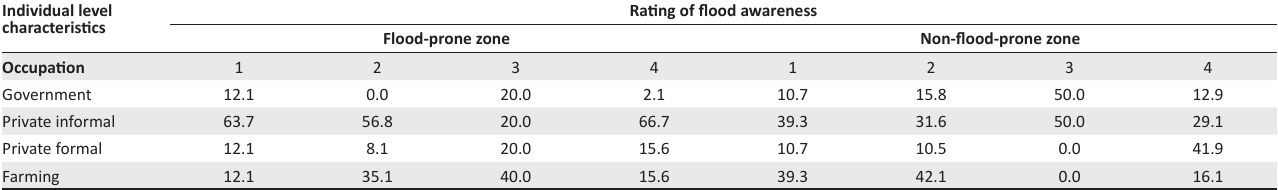
TABLE 4: Relationship between individual’s type of occupation and rating of flood awareness. Individual level